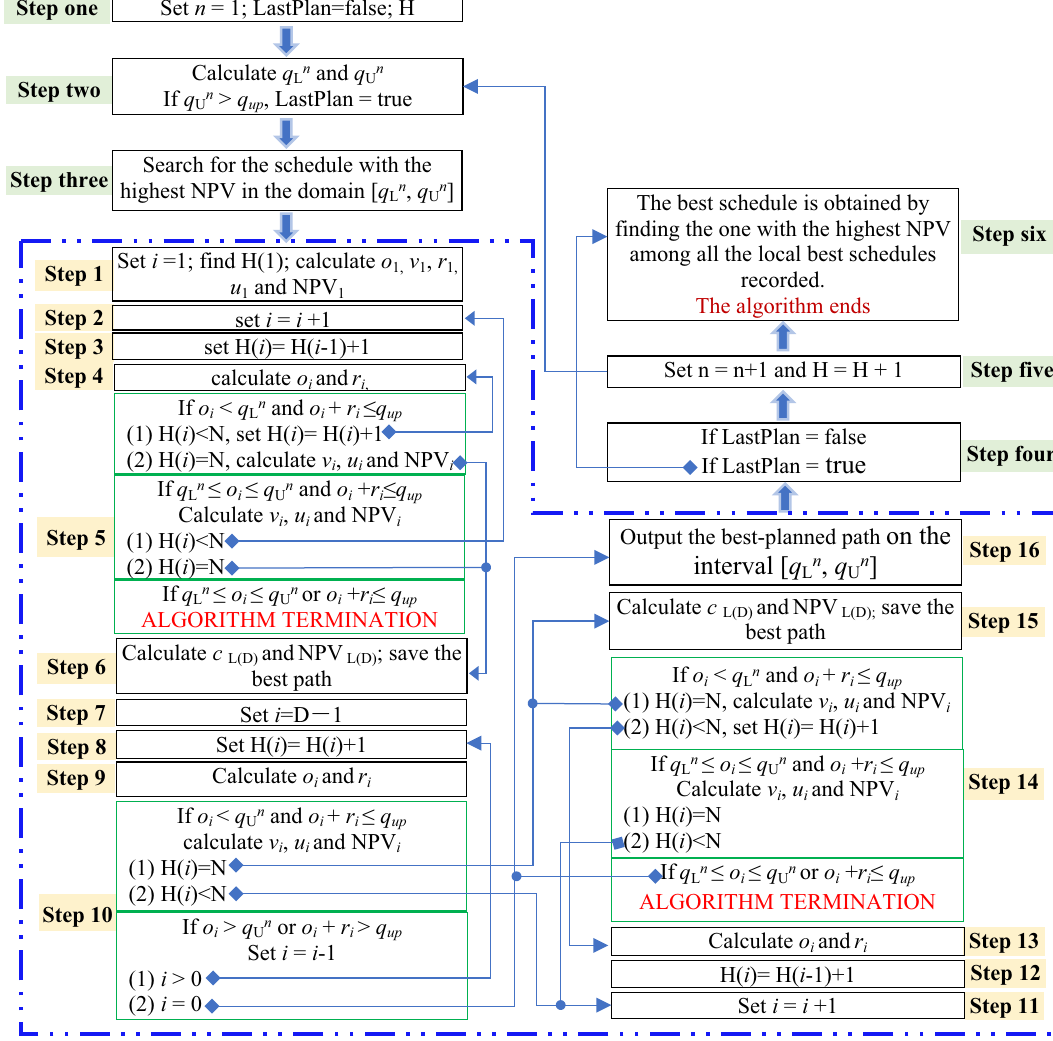
Figure 2. Flow chart of enumeration optimization algorithm for production scheduling.